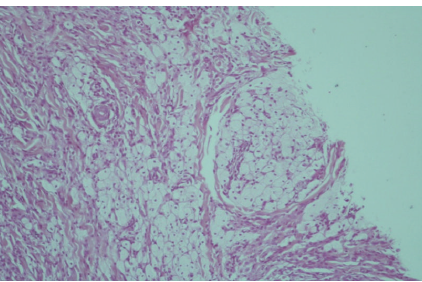
Figure 4: Papules, plaque, and tumor like lesions.